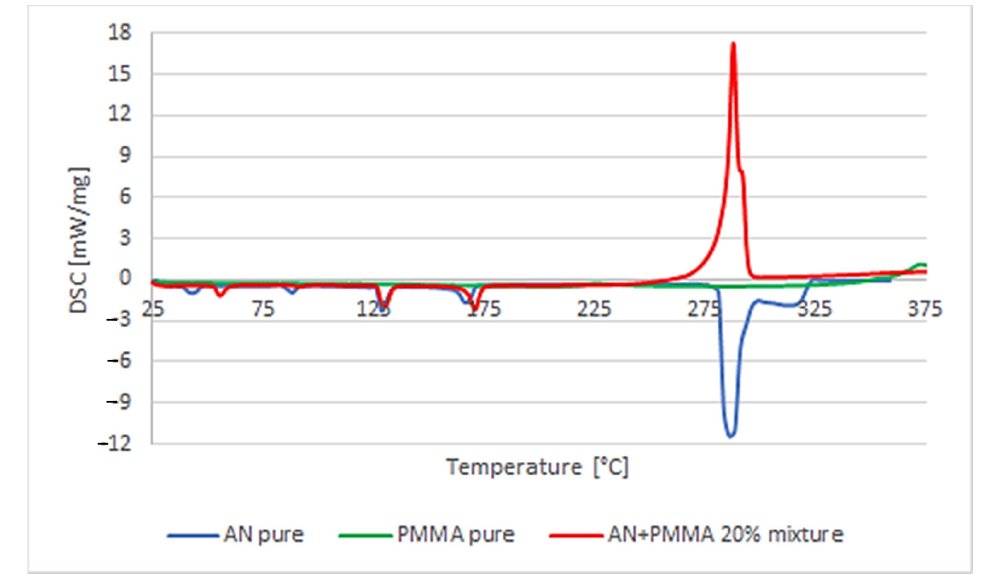
Figure 8. DSC analysis of AN, PMMA, and their mixture (20%), heat rate 10 °C/min.